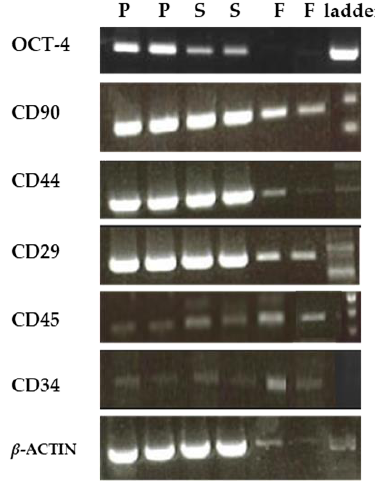
Figure 6. RT-PCR analysis of OCT-4, CD90, CD44, CD29, CD45, CD34, and β -ACTIN genes in SVF cells isolated from the peri-ovarian (P), subcutaneous abdominal (S), and falciform ligament (F) fats.